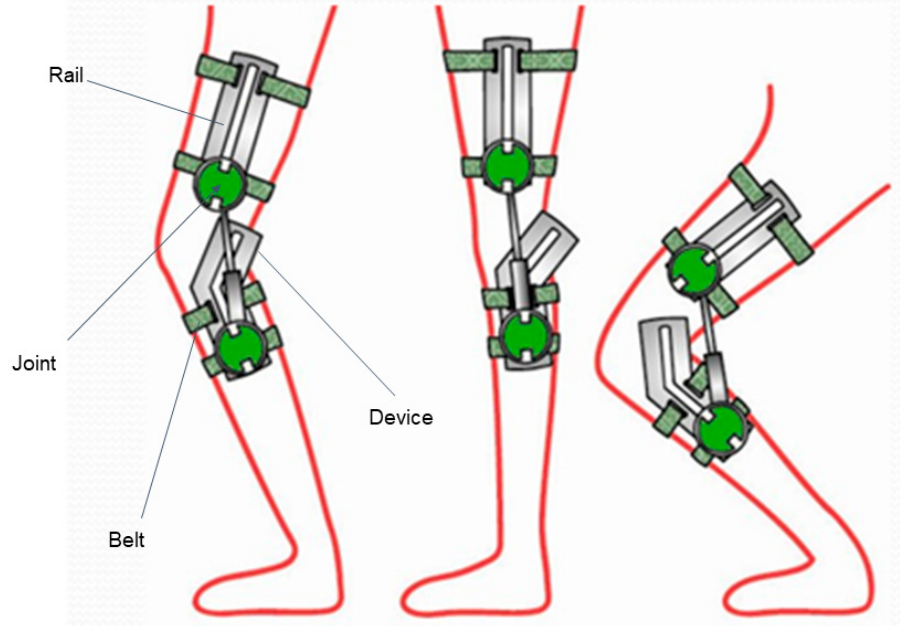
Figure 1. Knee supporter